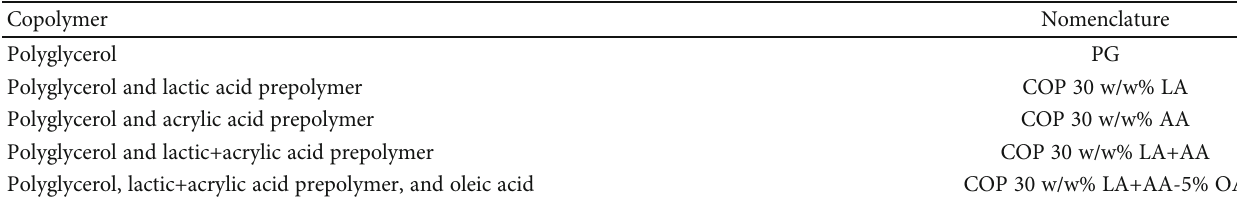
Table 1: Nomenclature of the synthesized polymers.